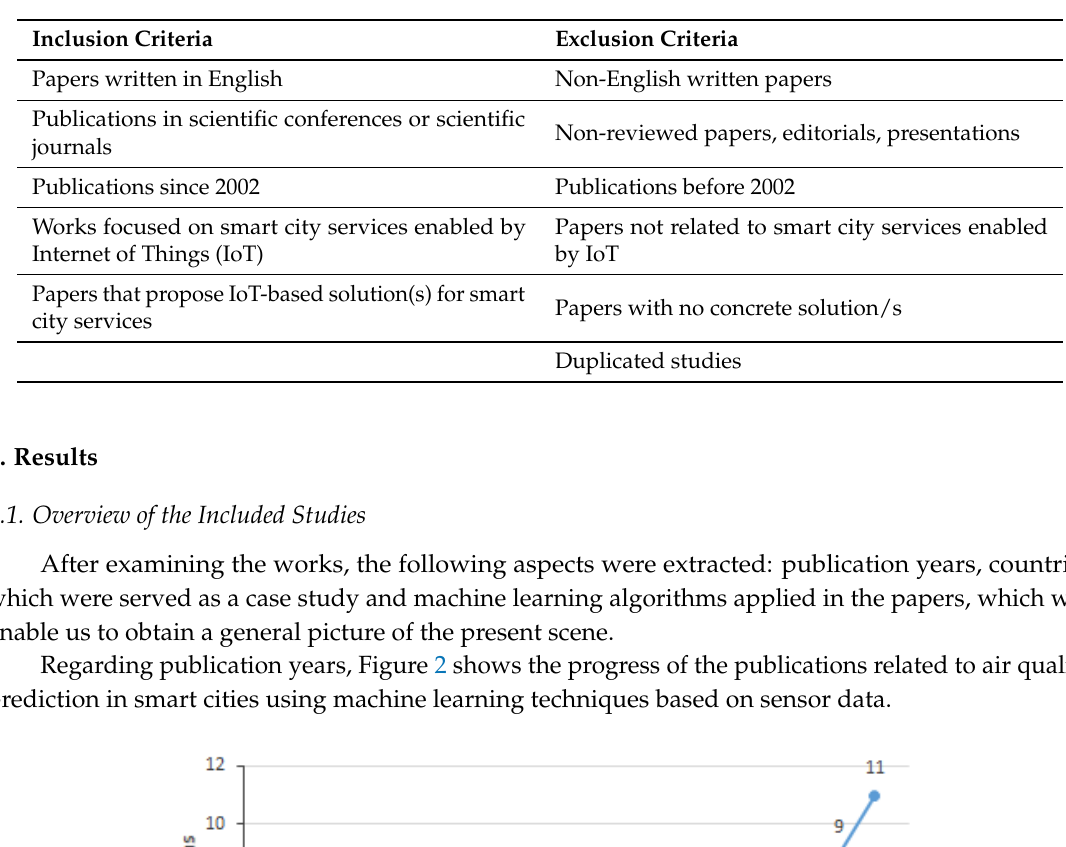
Table 1. Inclusion and Exclusion Criteria.